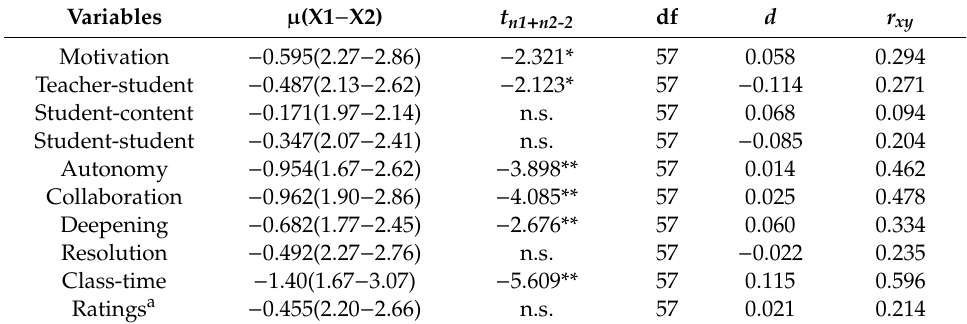
Table 3. Study of the value of independence between the groups (control and experimental) with